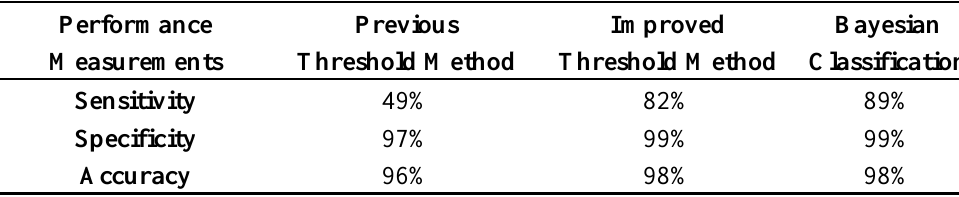
Table 2. Performance of the extraction